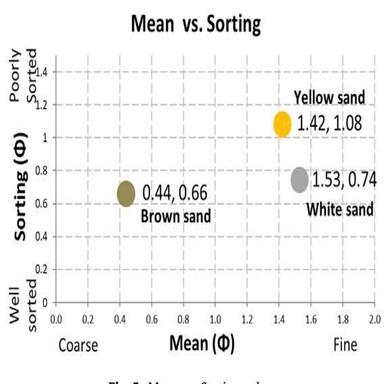
Mean vs. Sorting values. Fig. 6. Skewness vs. kurtosis values.